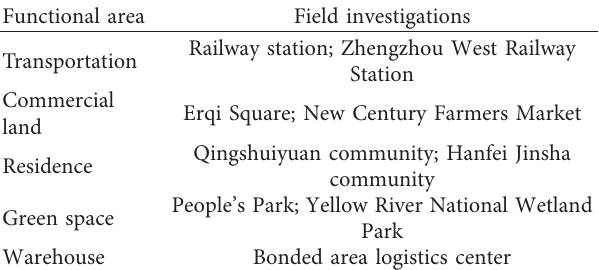
Table 1: Table of typical field survey areas. Functional